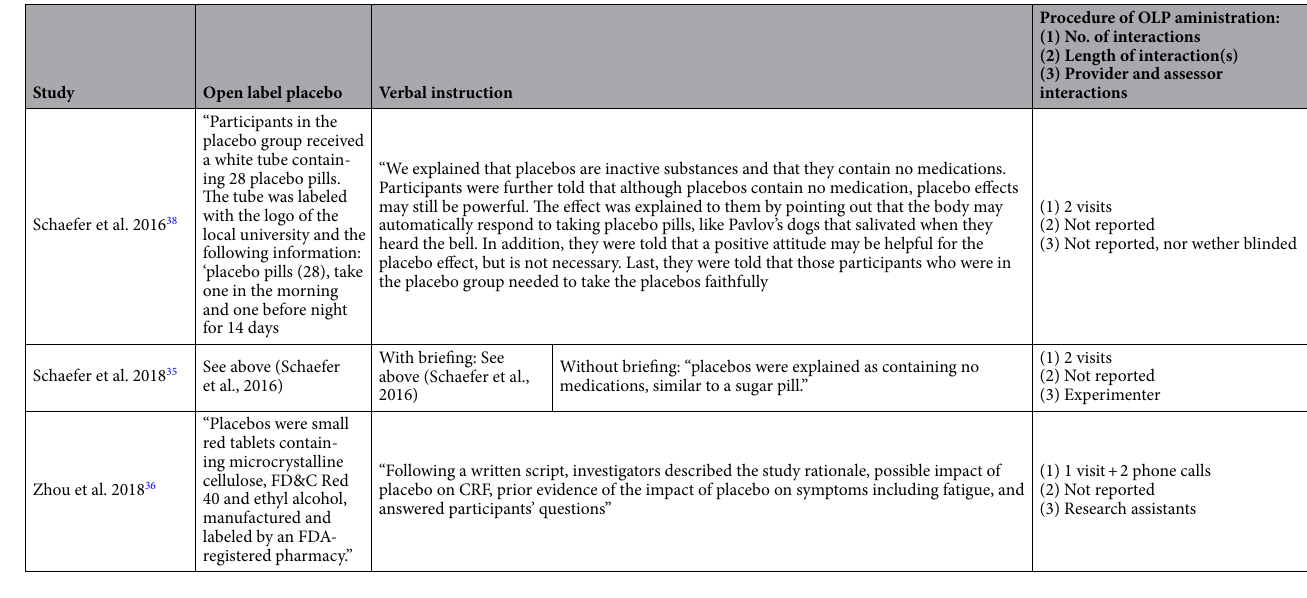
Table 3. Detailed description of interventions.